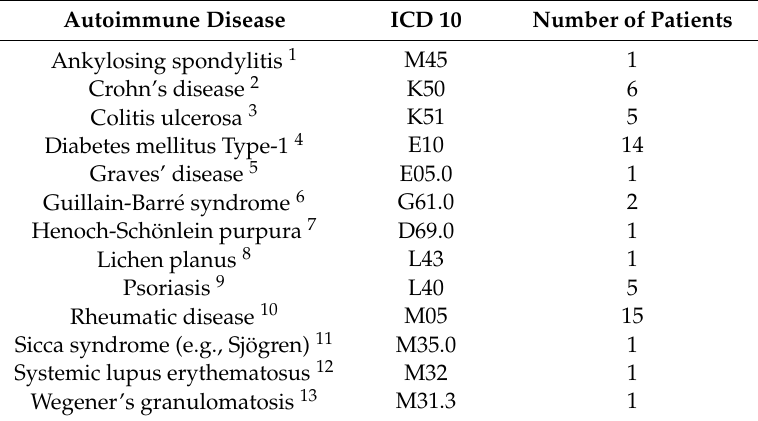
Table 3. Autoimmune diseases in the